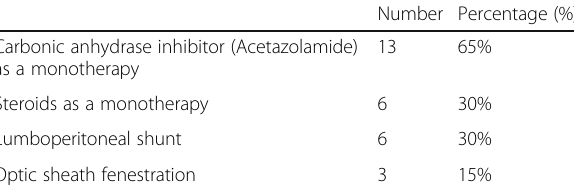
Table 3 Lines of treatment of IIH patients